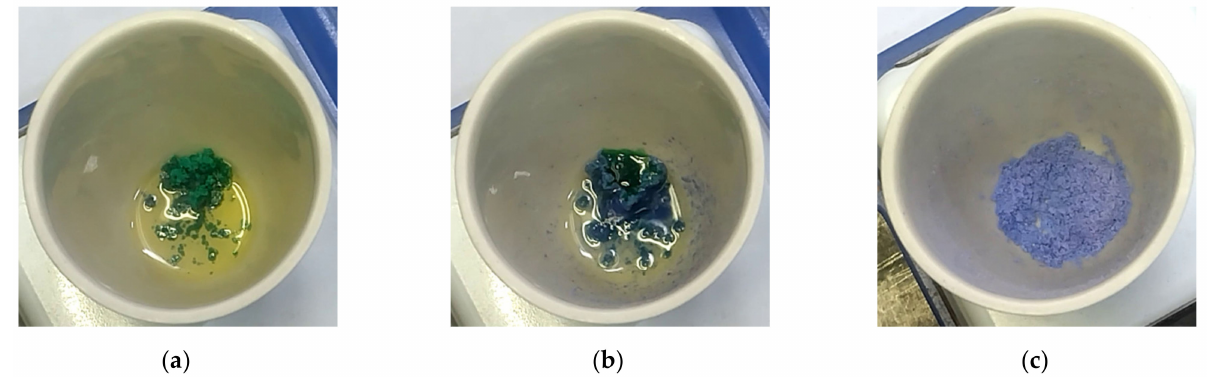
Figure 1. Synthesis of hexa(imidazole)nickel(II) nitrate by adding nickel nitrate to melted imidazole: ( a ) initial mixture; ( b ) 1 min; ( c ) 3 min. Table 1. Characteristics of the synthesized nickel complexes. Complex, Molar Mass Ni(C 3 H 4 N 2 ) 6 (NO 3 ) 2